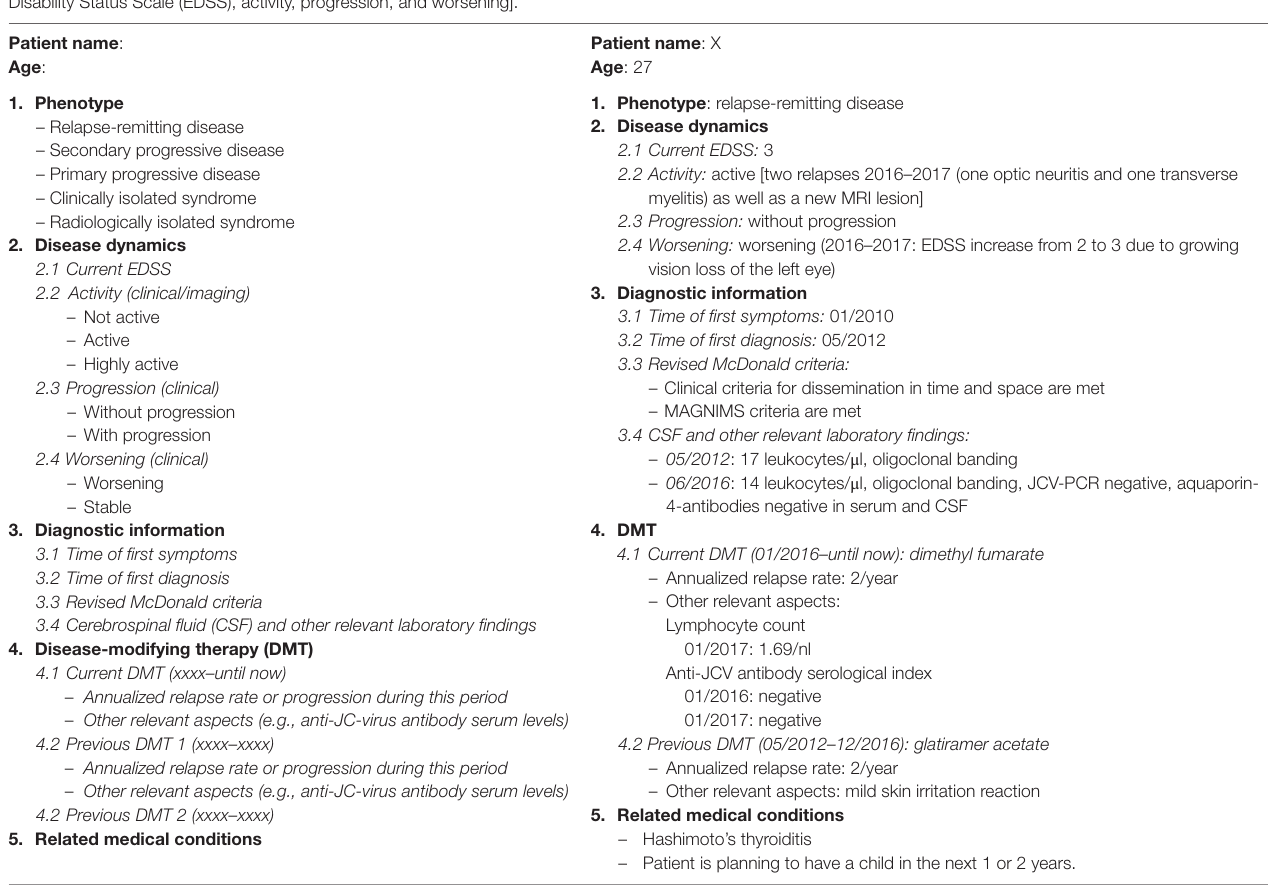
TAbLE 1 | On the left side of the table are the five dimensions of FAST with the available options which the clinician can choose between (e.g., “Phenotype” can be “relapse-remitting,” “secondary progressive,” etc.) and the different subdimensions [e.g., “Disease dynamics” is defined by information about the current Expanded Disability Status Scale (EDSS), activity, progression, and